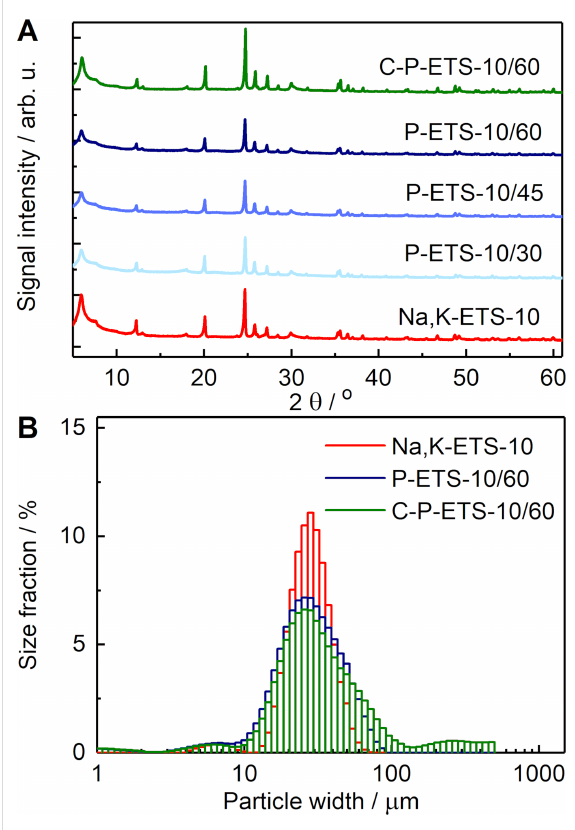
Figure 7: (A) XRD data of post-synthetically treated titanosilicates. The calculated crystallinity decreased to ≈ 70% for P-ETS-10/30, P-ETS-10/45 and P-ETS-10/60, and was restored to 100% for C-P-ETS-10/60 (assuming the parent material is 100%). (B) Particle size distribution obtained by laser diffraction for Na,K-ETS-10 (red), P-ETS-10/60 (blue) and C-P-ETS 10/60 (green).